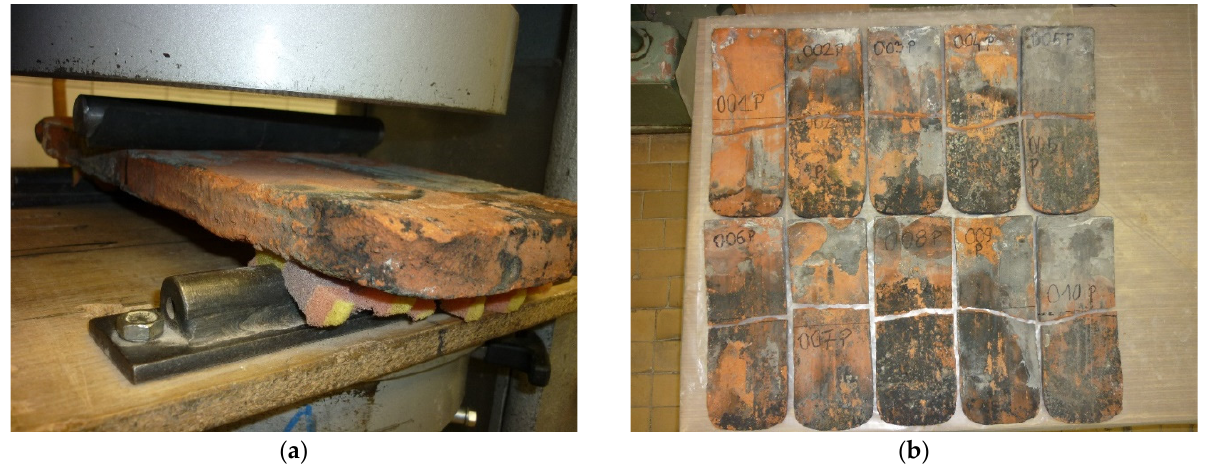
Figure 11. Flexural load capacity test: ( a ) tile in the testing machine during flexural capacity tests; ( b ) tiles (Nos. 001–010) after flexural strength tests.